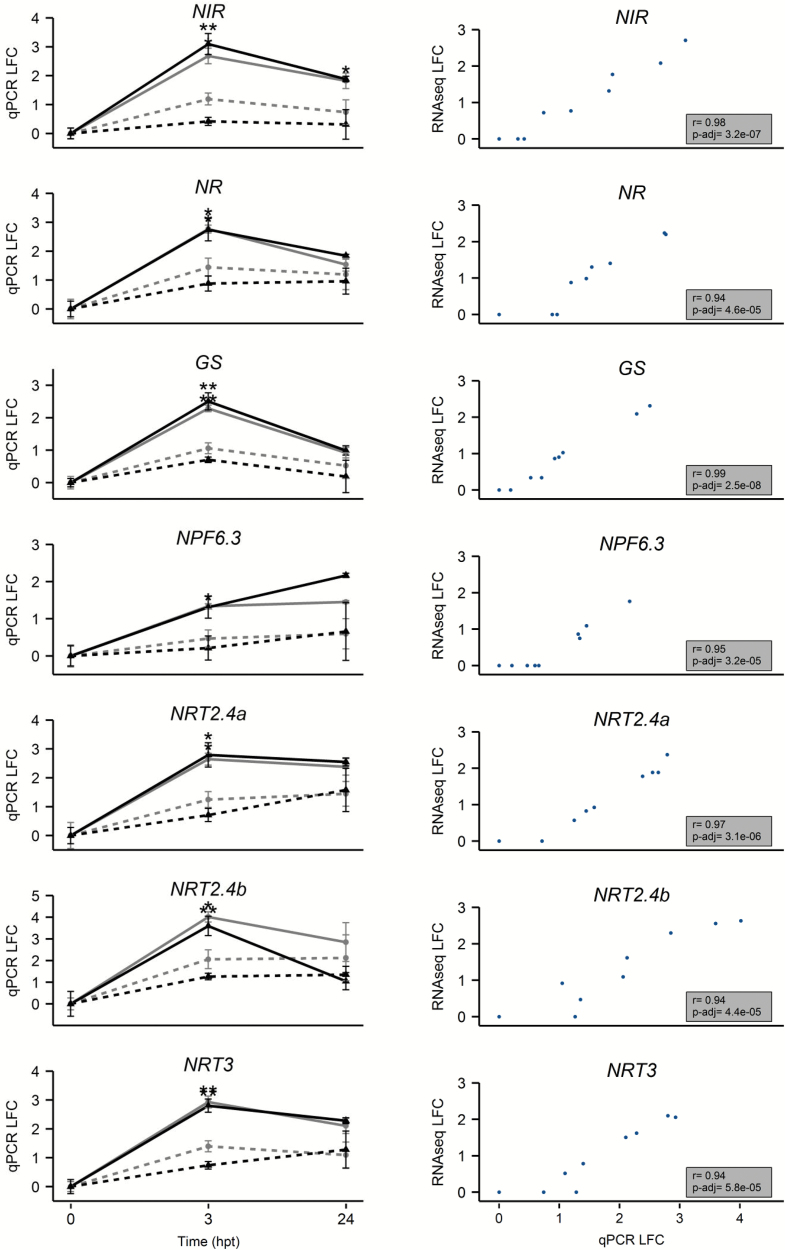
Validation of expression profiles of N-related genes by qPCR. Left panel, LFC values of normalized gene expression quantified using qPCR. Transcript levels are normalized to the reference genes EF1γ (VIT_12s0035g01130) and GAPDH (VIT_17s0000g10430) and relative to the control condition LN at 0 hpt for each combination. CS/1103P is represented in black and CS/RGM in grey. The HN condition is indicated by solid lines and the LN condition by dashed lines. Data are presented as mean±SE (n=3 biological replicates). Significant differences between conditions at each time point are indicated as *P<0.05 and **P<0.01 (Student’s t-test). Right panel. Pearson’s correlations of the LFC values obtained in qPCR (x-axis) and in RNA-seq with edgeR (y-axis) relative to the control condition LN at 0 hpt for each combination. The correlation coefficient and P-value (Bonferroni adjusted) are presented in the grey boxes. (This figure is available in colour at JXB online.)